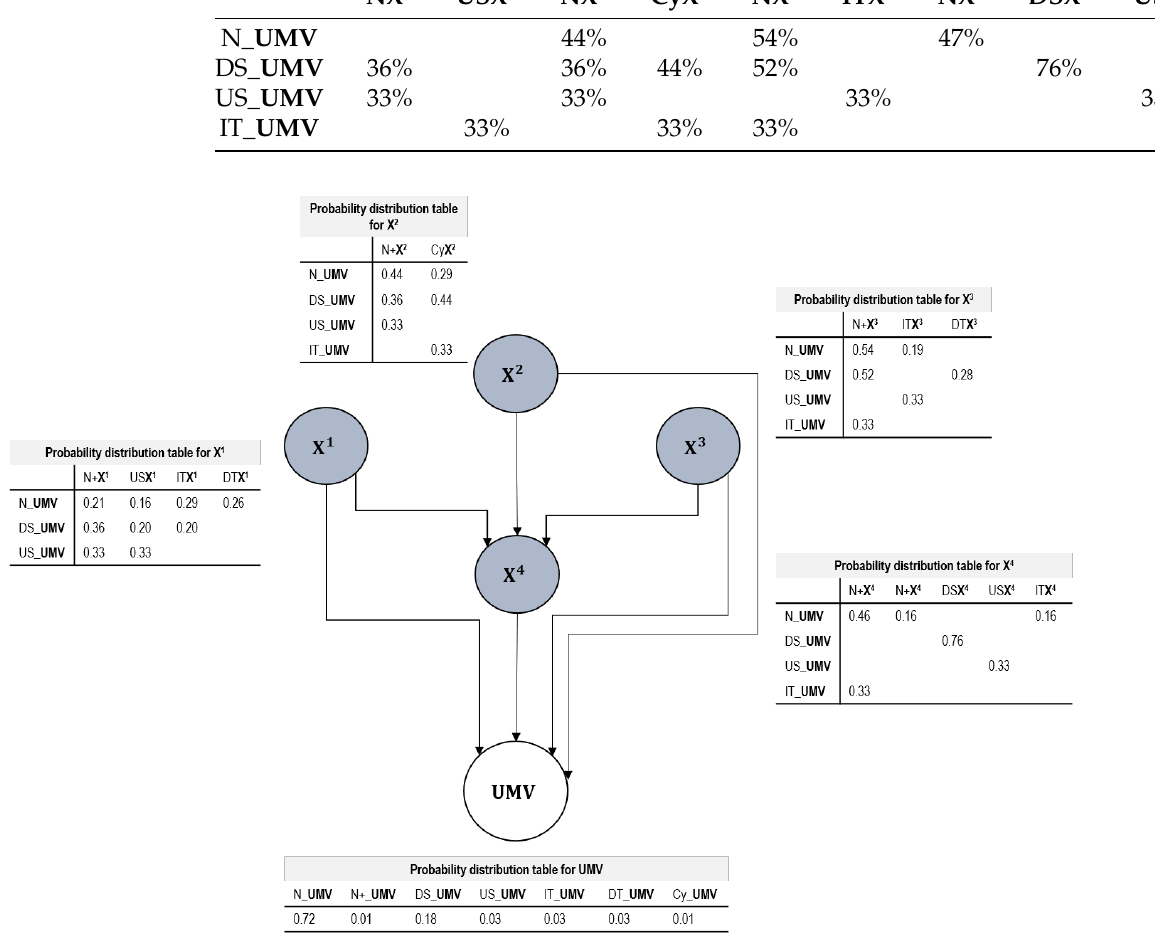
Figure 9. Bayesian Network diagram for variables with real